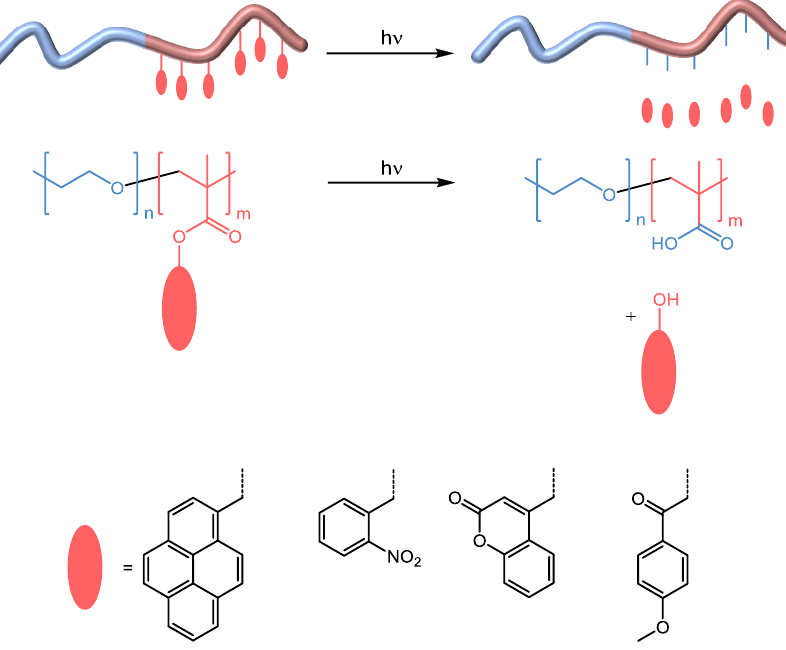
Figure 5. Schematic representation of UV light triggered photo-cleavage of pyrenylmethyl, o -nitrobenzyl, coumarinyl and p -methoxy-phenacyl esters within block copolymer materials.